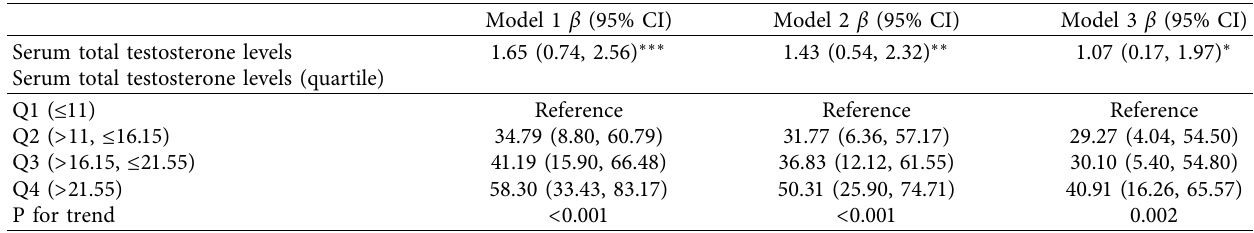
Table 2: Association between serum total testosterone levels (ng/dL) and lumbar bone mineral density (mg/cm 2 ).